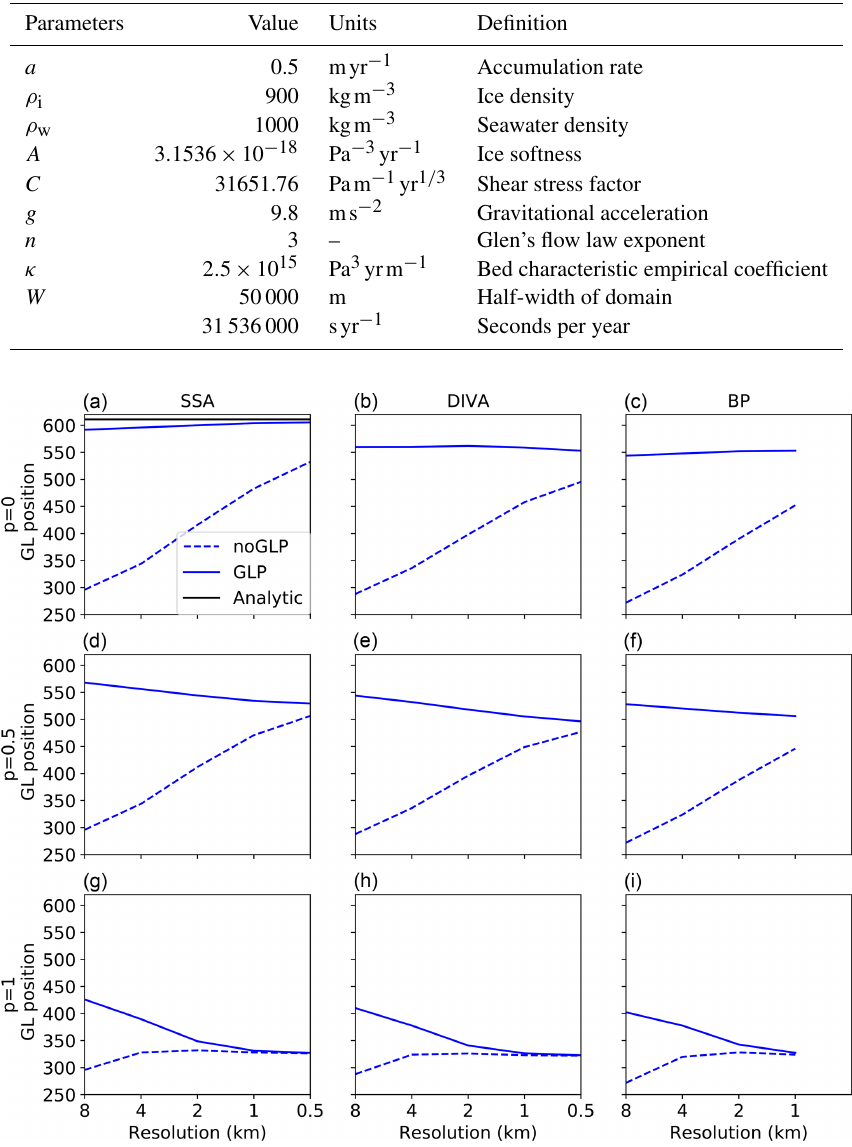
Figure 4. Location of the central grounding line (km) as a function of grid resolution (km) at the end of the MISMIP3d Stnd experiments for SSA (a, d, g) , DIVA (b, e, h) , and BP (c, f, i) and using p = 0 (a, b, c) , p = 0 . 5 (d, e, f) , and p = 1 (g, h, i) , without a GLP (dashed lines) and with a GLP (solid lines). The semi-analytic solution from Schoof (2007a) is shown in black for SSA and p =